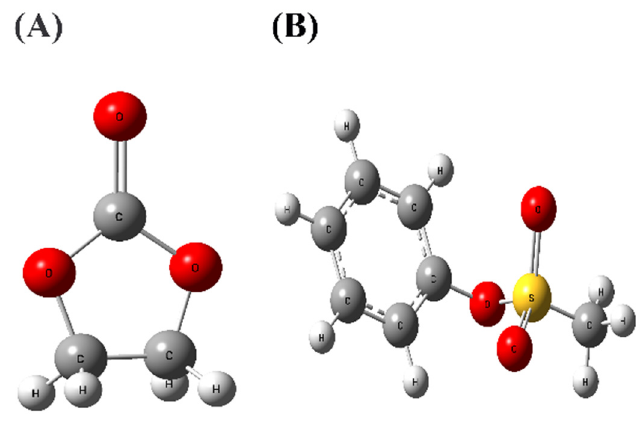
Figure 1. The chemical structures of ( A ) EC and ( B ) PMS.